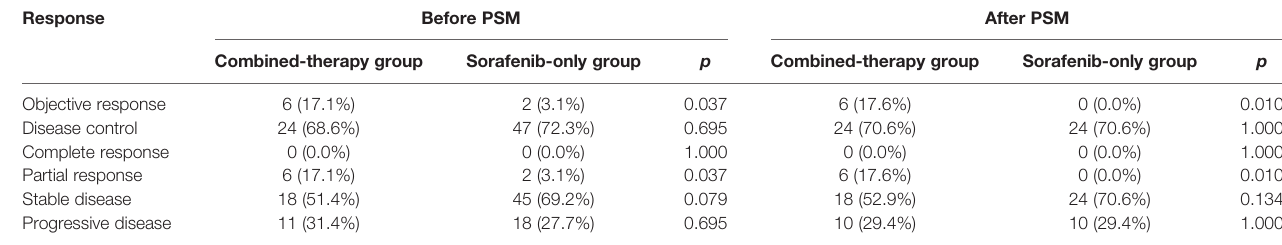
TABLE 2 | Tumor responses for patients with advanced hepatocellular carcinoma. Response Before PSM After PSM Combined-therapy group Sorafenib-only group p Combined-therapy group Sorafenib-only group p Objective response